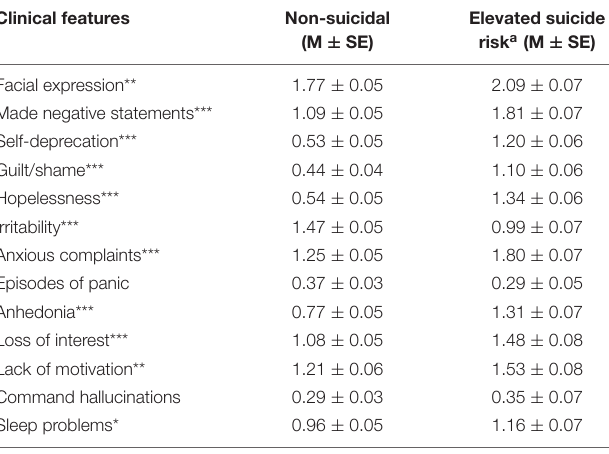
TABLE 4 | Mental state indicators of non-suicidal and elevated suicide risk